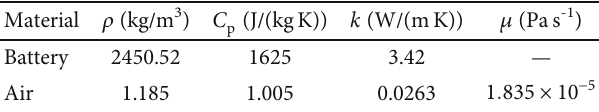
Figure 3: Schematic of the experimental system. Table 2: Material properties used in the simulation.